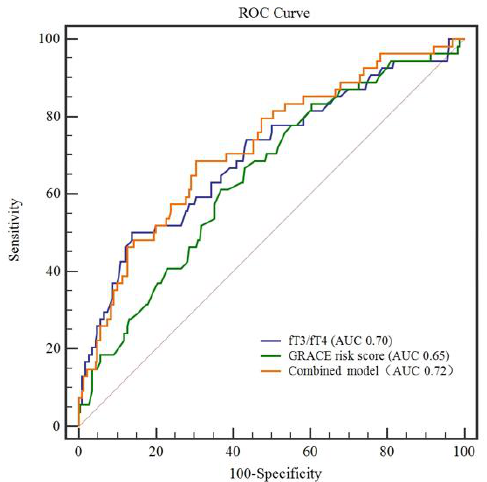
Figure 3. The receiver-operating characteristic (ROC) curve for FT3/FT4 ratio, the Global Registry of Acute Coronary Event (GRACE) risk score, and the combined value for predicting major adverse cardiac events (MACE). FT3, free triiodothyronine; FT4, free